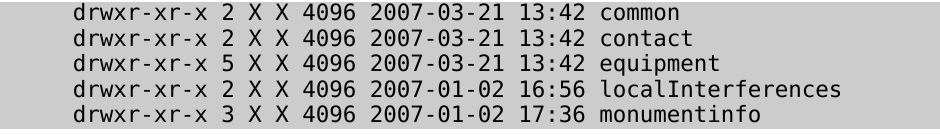
Fig 4. Folders of XSD files